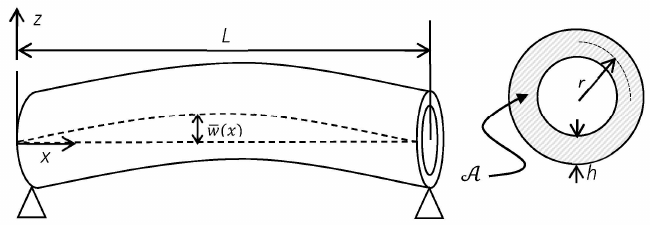
Figure 1. An initially curved beam with annular cross-section representing a SWCNT.